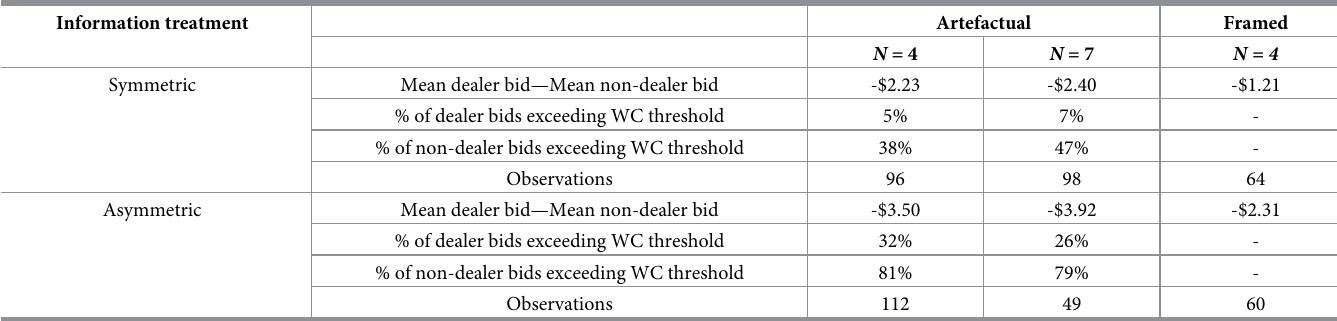
Table 4. Sample statistics from